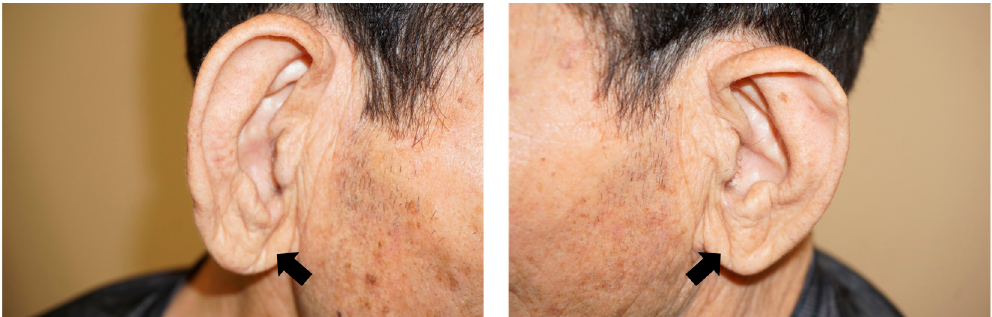
Figure 2. Representative pictures of grade 3 earlobe crease (arrows).